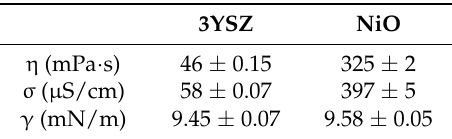
Figure 4. ( A ) Conductivity of a 0.21 M Ni(NO 3 ) 2 solution in various solvents; ( B ) conductivity of a 0.21 M Ni(NO 3 ) 2 solution in 2-ME at different molar ratios citric acid (CA):Ni; ( C ) conductivity of a 0.21 M Ni(NO 3 ) 2 solution in 2-ME with different polymer concentrations; ( D ) viscosity of a 0.21 M Ni(NO 3 ) 2 solution in 2-ME with different polymer concentrations. The conductivity of the final 0.21 M Ni(NO 3 ) 2 solution and the standard 3YSZ are also plotted as reference; and ( E ) electrospun NiO microfibers from a 0.21 M Ni(NO 3 ) 2 solution in 2-ME with 70 mg/mL of PVP at a molar ratio CA:Ni of 6:1. Table 1. Solution properties of three percent yttria partially-stabilized zirconia (3YSZ) and NiO precursor solutions. 3YSZ solution has a precursor concentration of 0.65 M and PVP concentration of 10 mg/mL. NiO precursor solution has a precursor concentration of 0.21 M in 2-ME with 70 mg/mL of PVP and citric acid in 6:1 CA:Ni molar ratio.